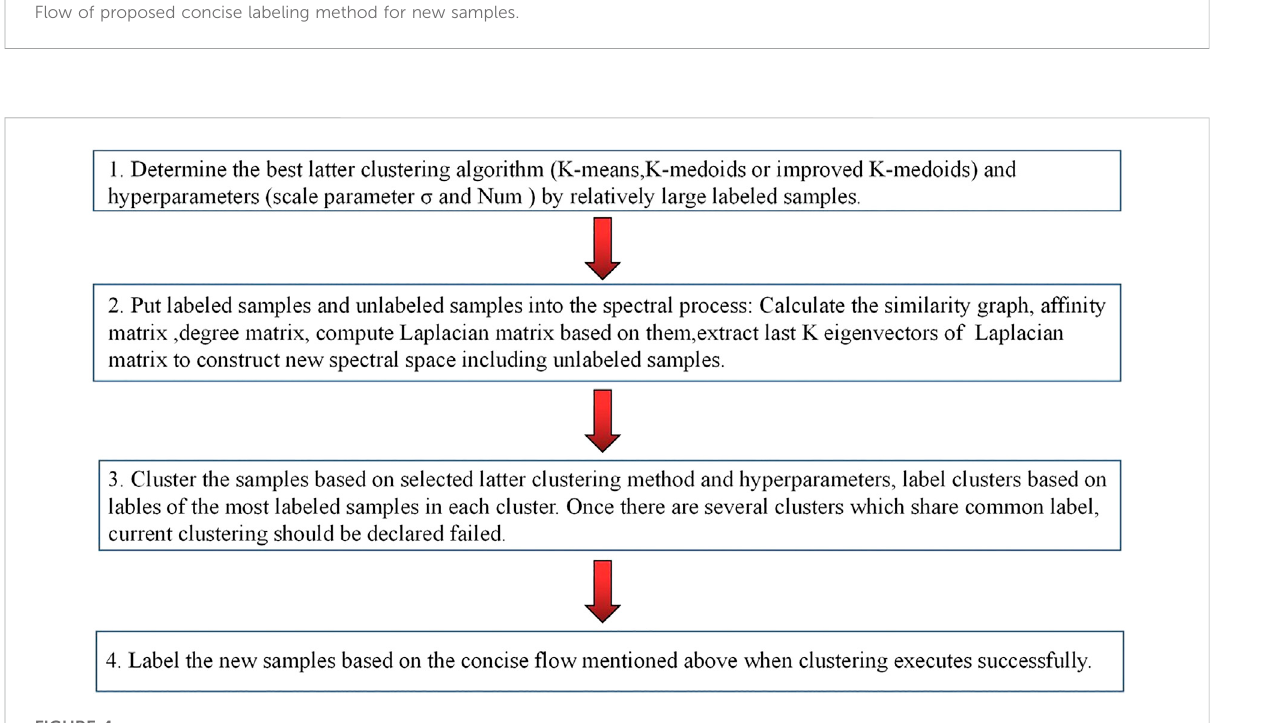
FIGURE 4 Flow of predicting new unlabeled samples based on spectral clustering